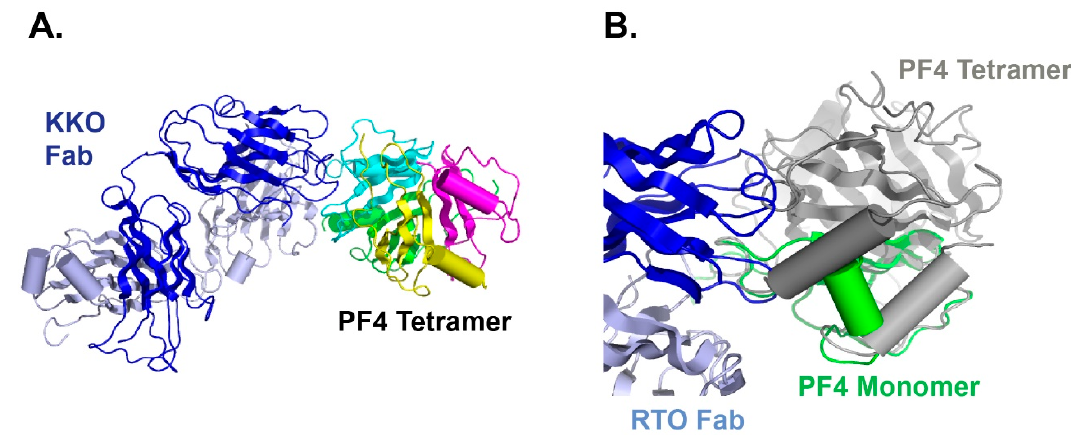
Figure 3. RTO binding to PF4 monomer impedes PF4 from forming tetramers, thus prevent PF4 tetramer-based immune complex formation, which underlies the pathogenesis of HIT. ( A ) HIT-like antibody KKO (blue) binds to PF4 tetramers (green, yellow, cyan and magenta; ( B ) blocking antibody RTO (blue) binds to PF4 monomer (green) and prevents tetramer (gray) formation. KKO and RTO have shared but not identical epitopes [61,102] (Figure 4). To verify that RTO can